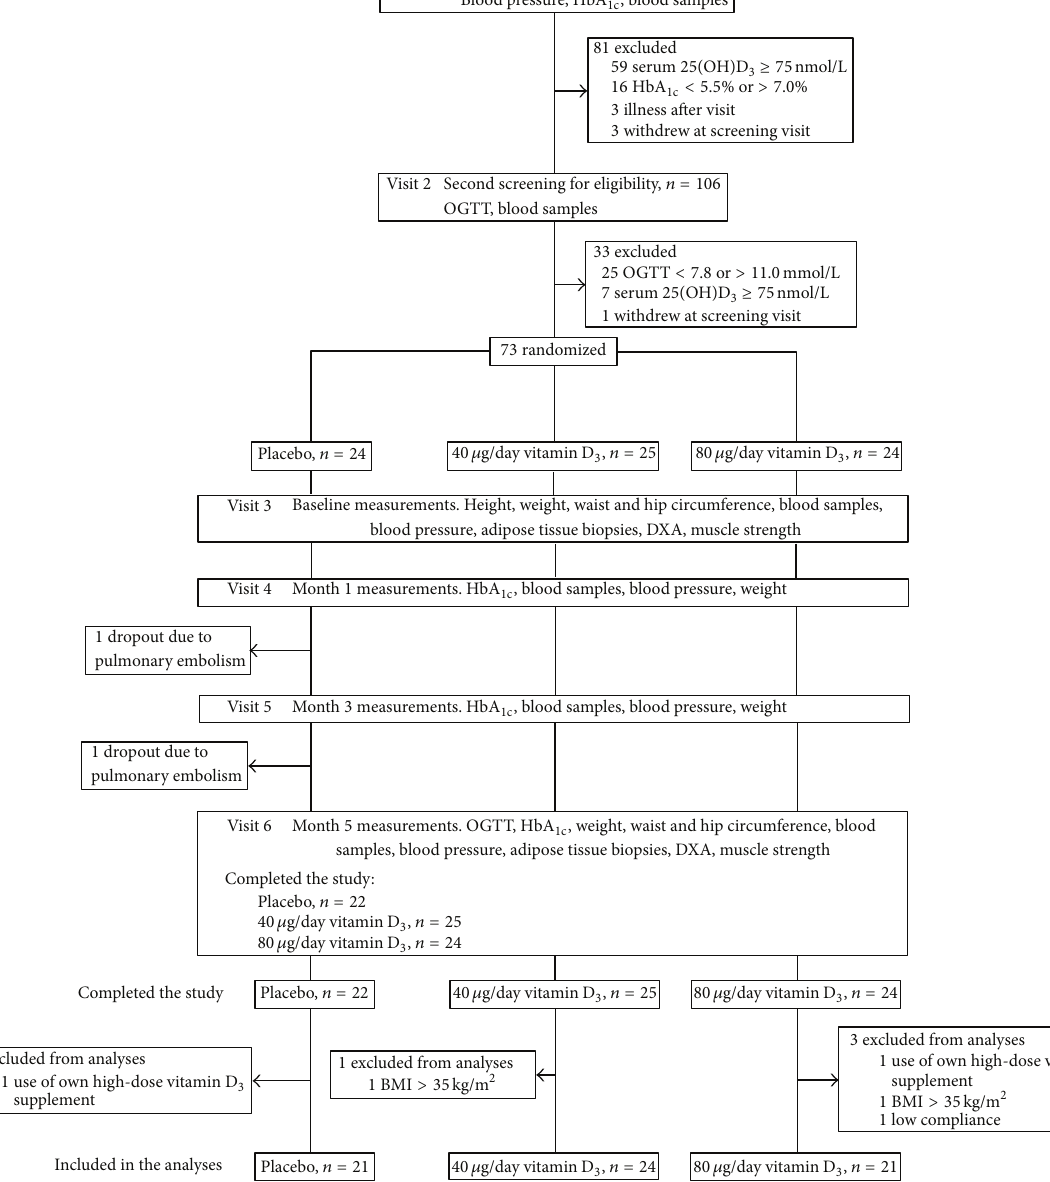
Figure 1: Flow diagram of the study. 25(OH)D 3 : 25-hydroxyvitamin D 3 ; BMI: body mass index; OGTT: oral glucose tolerance test.